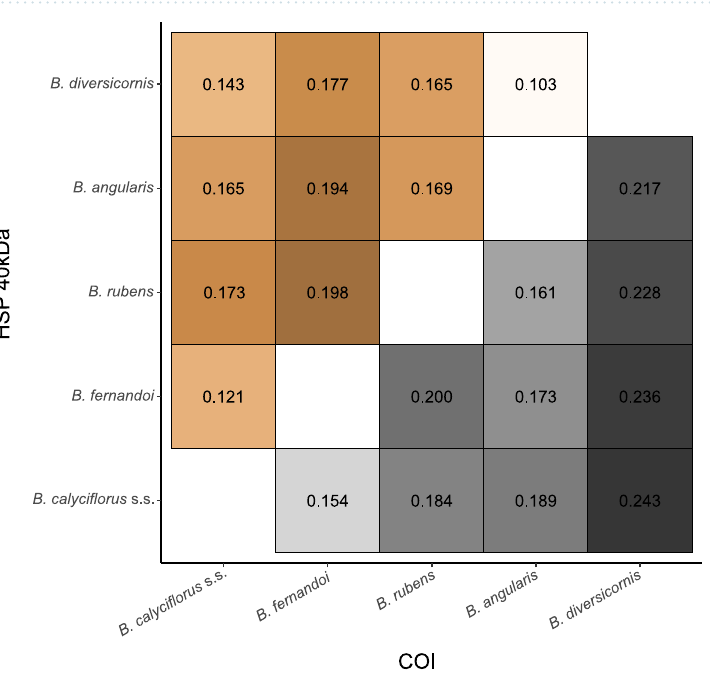
Figure 2. Nucleotide divergence of nuclear and mitochondrial genes. Nucleotide divergence of the nuclear HSP 40 kDa (orange) and the mitochondrial Cytochrome Oxidase Subunit I (COI) (grey) genes, based on comparisons of B. calyciflorus s.s., B. fernandoi, B. rubens , B. angularis , and B. diversicornis . The colour intensity indicates increasing nucleotide divergence between the compared